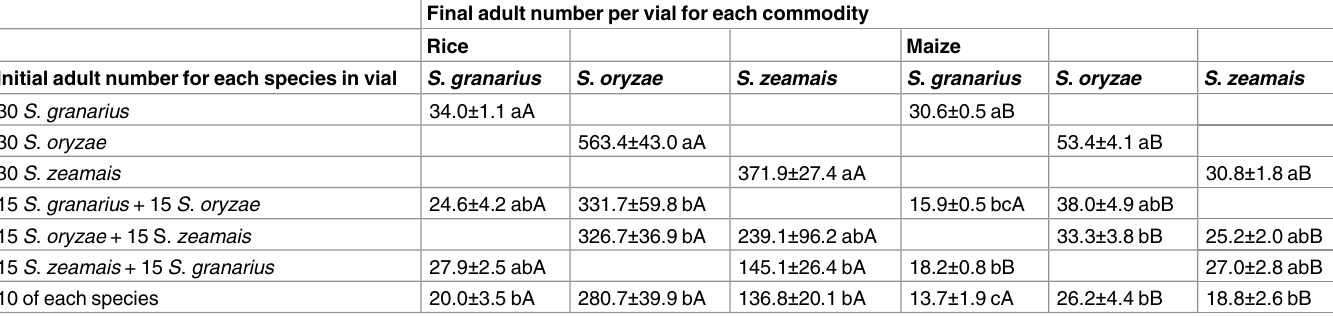
Within each column, means followed by the same lowercase letter are not significantly different (F values ranged between 3.7 and 47.6, p values ranged between between 0.02 and < 0.01, Tukey-Kramer HSD test at p = 0.05; in all cases df = 3, 32). Within each row, means followed by the same uppercase letter are not significantly different (F values ranged between 2.1 and 154.4; p values ranged between 0.16 and < 0.01, Tuckey-Kramer HSD test at p = 0.05; in all cases df = 1,